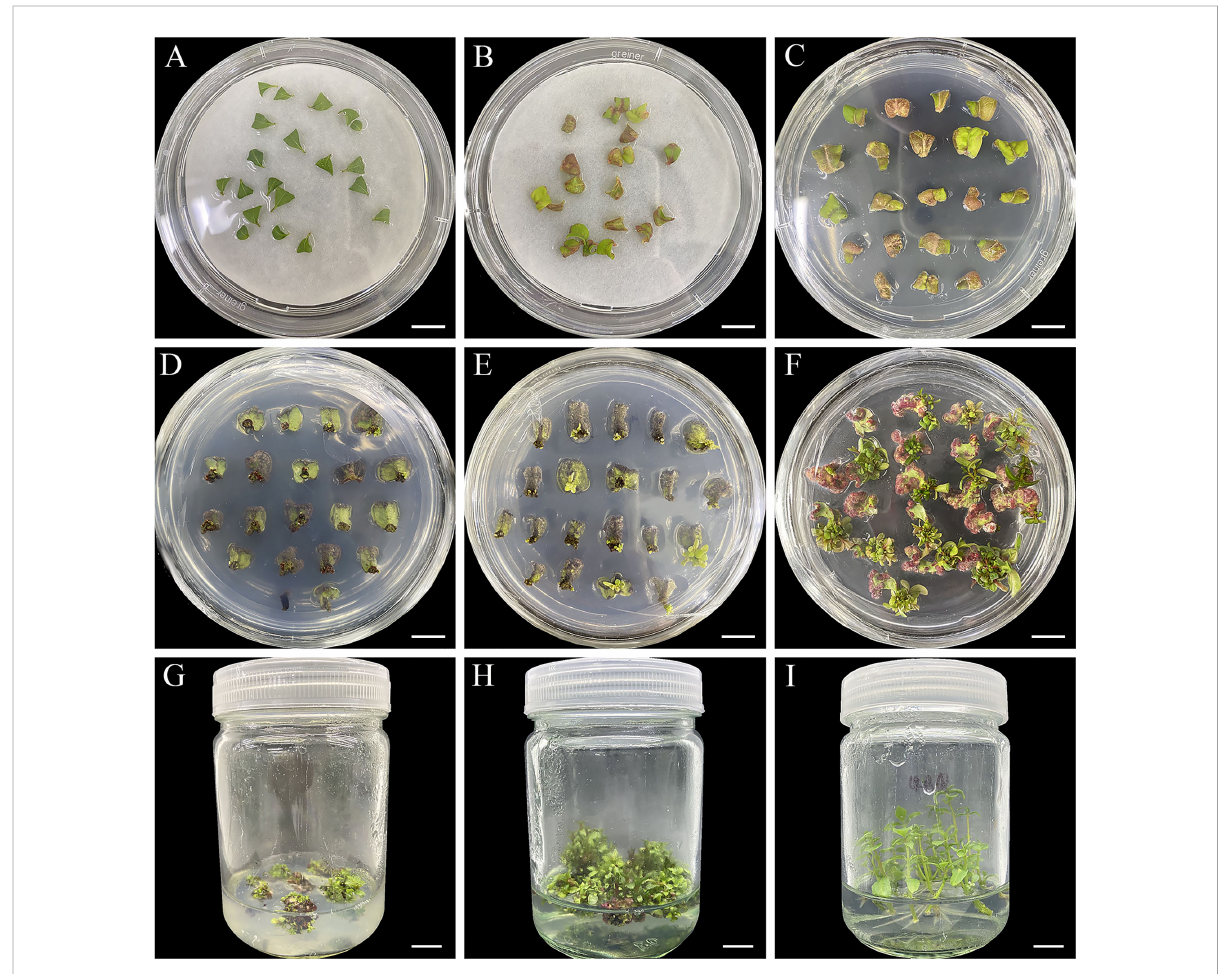
FIGURE 2 Adventitious bud regeneration from leaves of E. urophylla × E. grandis DH32-29. The explants were cultured in the medium for (A) 0, (B) 3, (C) 15, (D) 30, (E) 45, and (F) 60 days. Regenerated buds are propagated (G, H) and rooted (I) . Scale bar: 1